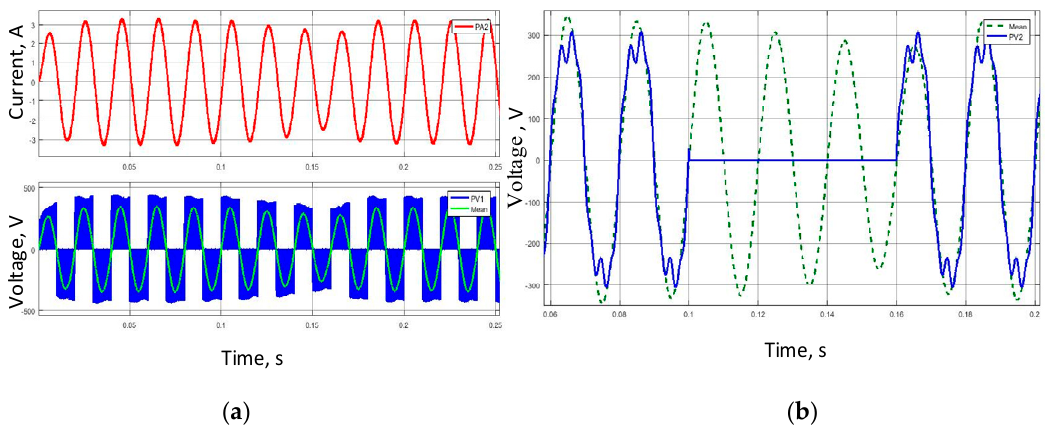
Figure 8. Modeling of the circuit with a single-phase SST: ( a ) the SST-load current and voltage (green line is the average voltage); and ( b ) the comparison of input and output voltage in the SST.